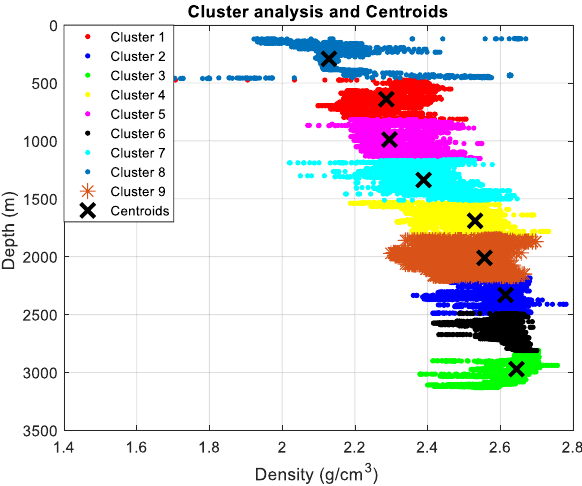
Fig. 6 Well-3 cluster analysis of density log